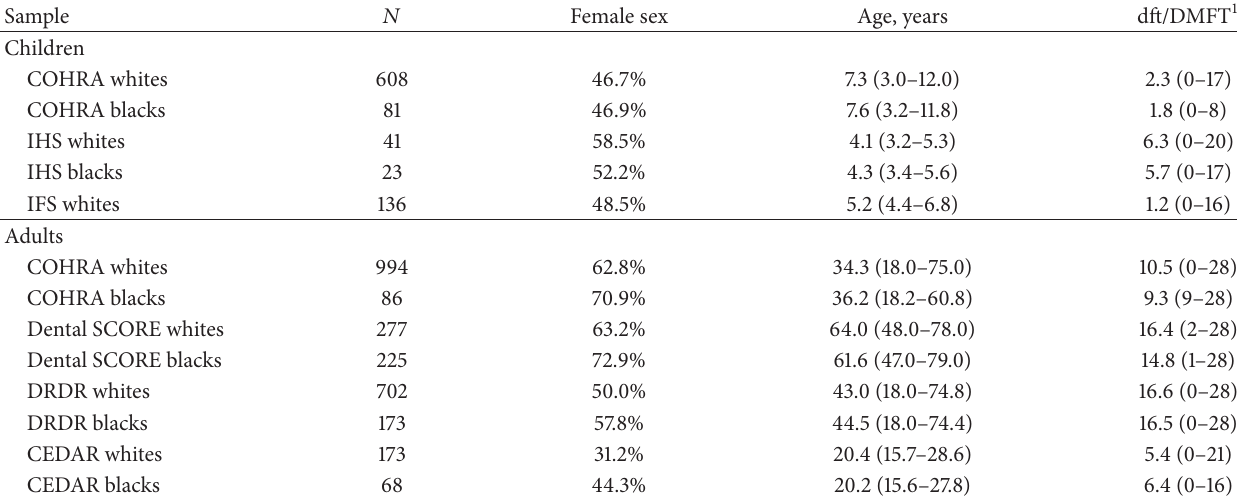
Table 1: Characteristics of the samples: mean (range) or percentage, %.